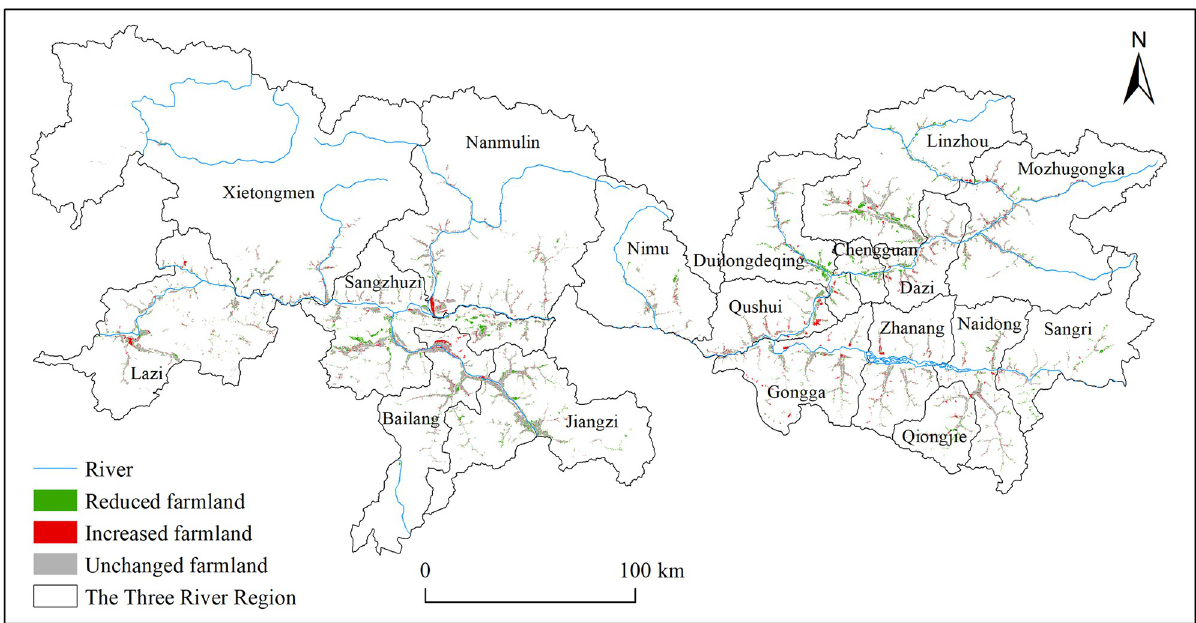
Fig 2. Farmland changes between 2000 and 2018 in the Three River Region. The map was prepared with ArcGIS10.1 (https://resources.arcgis.com/ en/help/), based on the maps of China political boundaries and rivers from the Resource and Environment Science and Data Center, CAS (https://www. resdc.cn/), with the permission of its copyright, and farmland data from Wei et al., [34]